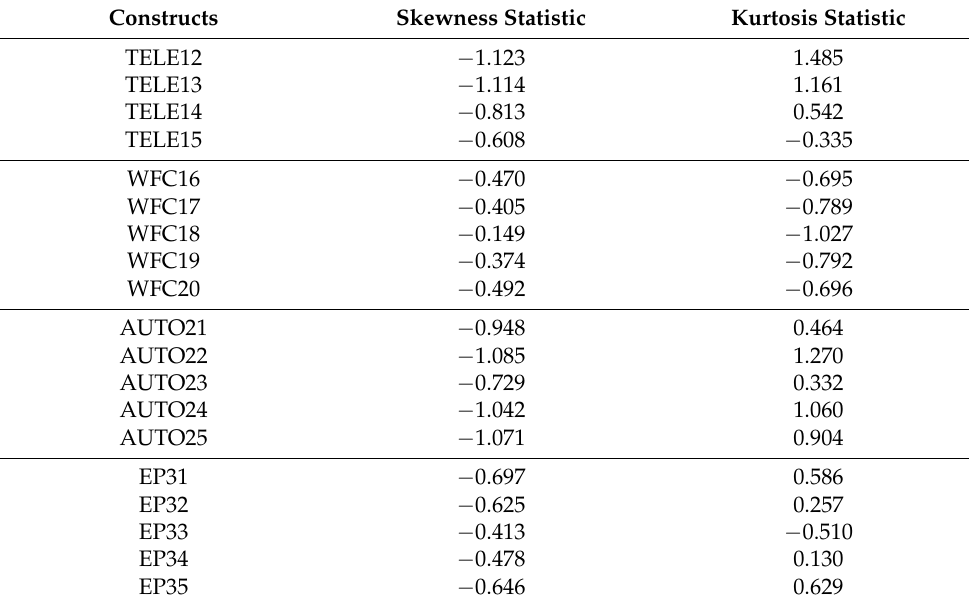
Table 2. Descriptive Statistics.